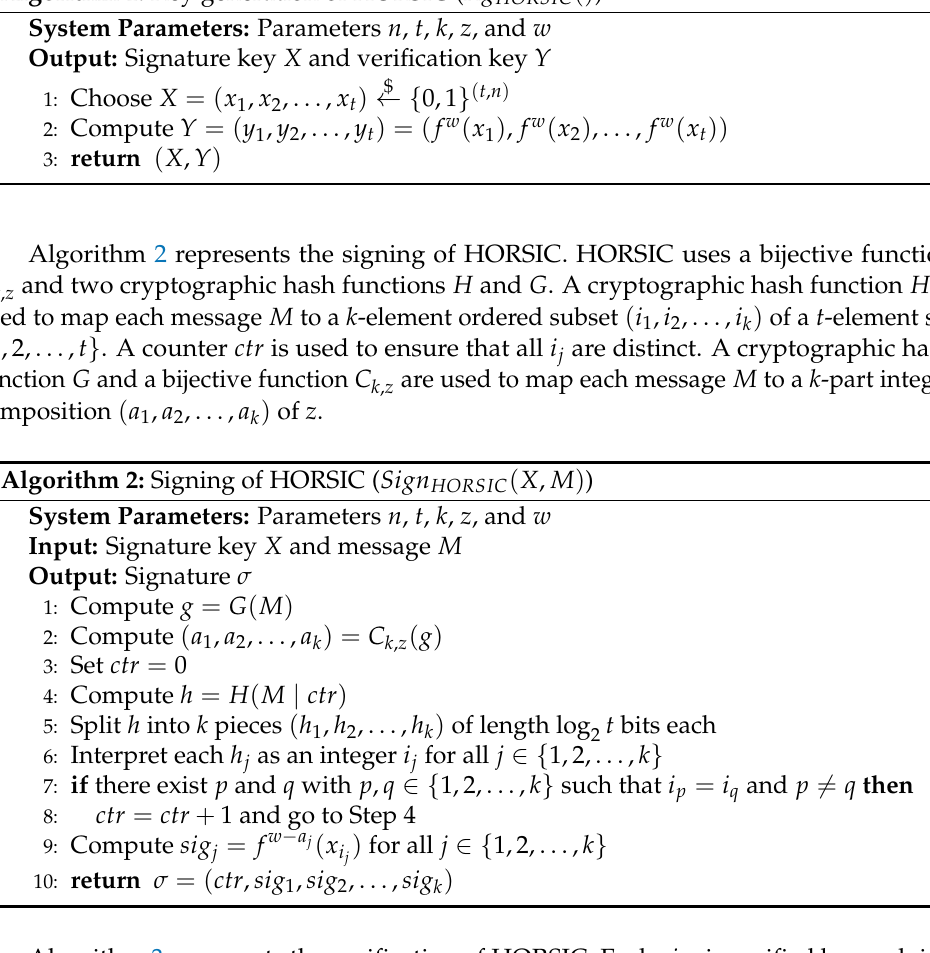
Algorithm 1: Key generation of HORSIC ( Kg HORSIC () )